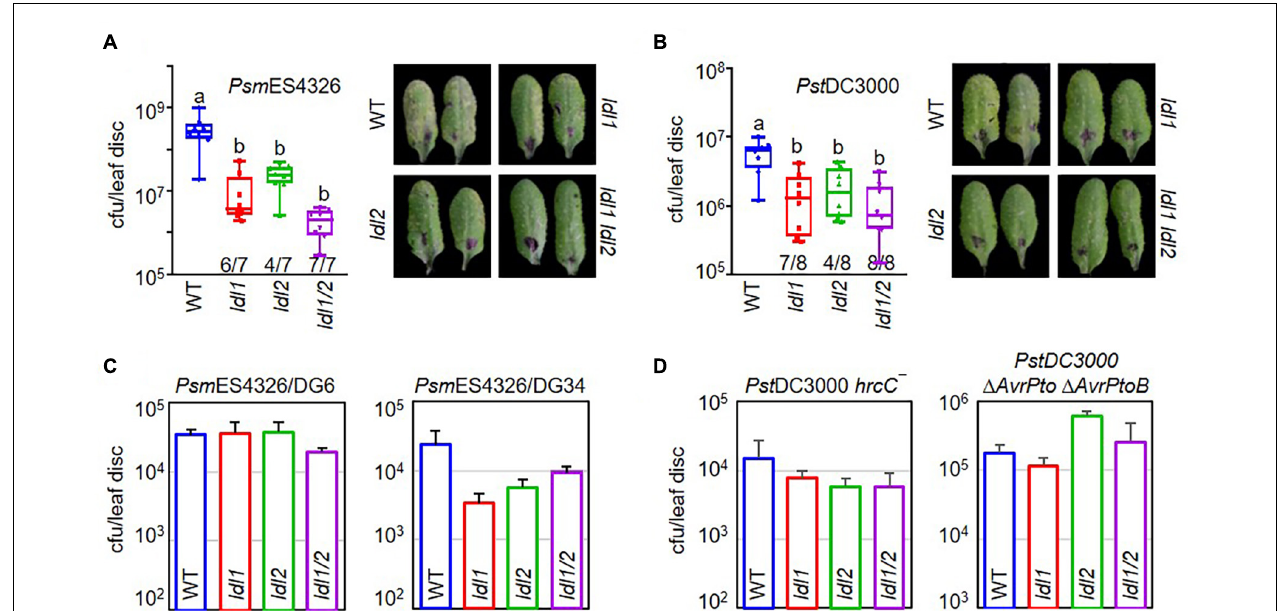
FIGURE 1 | The hyper-resistance response of ldl1 ldl2 double mutants to virulent Pseudomonas infection is more stable than that of the single mutants. (A , B) The growth of P. syringae pv. maculicola ES4326 ( Psm ES4326, OD 600 = 0.0001) (A) and P. syringae pv. tomato DC3000 ( Pst DC3000, OD 600 = 0.0001) (B) in WT, ldl1 , ldl2 , and ldl1 ldl2 plants at 3 days post inoculation (dpi). The denominators and numerators under the box plots indicate the number of total repeats and the number of trials showing differences from WT, respectively. Box plots show the minimum, first quartile, median, third quartile, and maximum values. The right panels show disease symptoms of each genotype caused by P . syringae infection. (C , D) WT-like disease responses of single and double mutants against infection with different avirulent derivatives of Psm ES4326 carrying AvrRpt2 ( Psm ES4326/DG6, OD 600 = 0.0001) and AvrRpm1 ( Psm ES4326/DG34, OD 600 = 0.0001) (C) and attenuated mutants of Pst DC3000 hrcC − (OD 600 = 0.001) and Pst DC3000 (cid:49) AvrPto (cid:49) AvrPtoB (OD 600 = 0.001) (D) . The area of a leaf disc is 0.78 cm 2 . Bar indicates the average ± standard error (SEM) ( p < 0.05, ANOVA-Tukey, n = 8). The experiments were repeated 3, 6, and 3 times for the avirulent derivatives ( Psm ES4326/DG6 and Psm ES4326/DG34), Pst DC3000 hrcC − , and Pst DC3000 (cid:49) AvrPto (cid:49) AvrPtoB , respectively, with similar